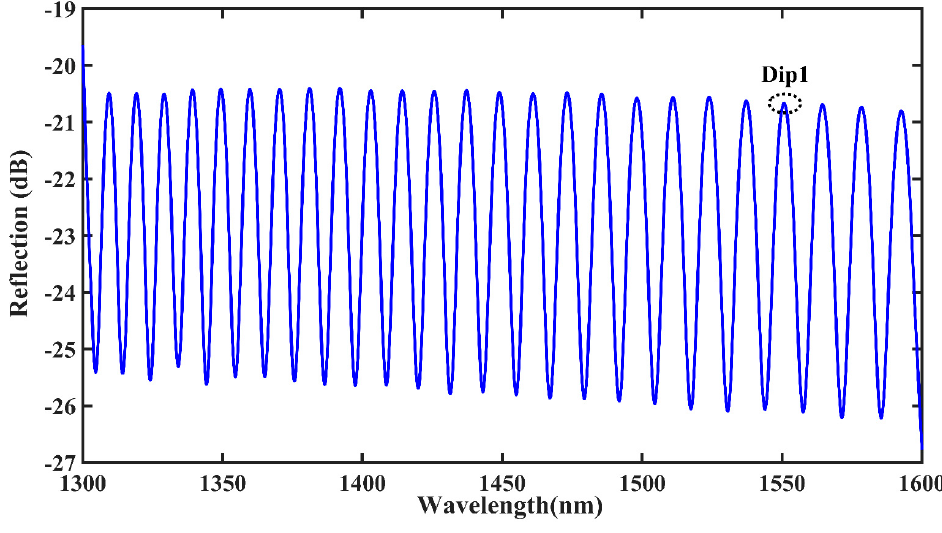
Figure 2. Original spectrum of single bubble. Materials 2023 , 16 , x FOR PEER REVIEW